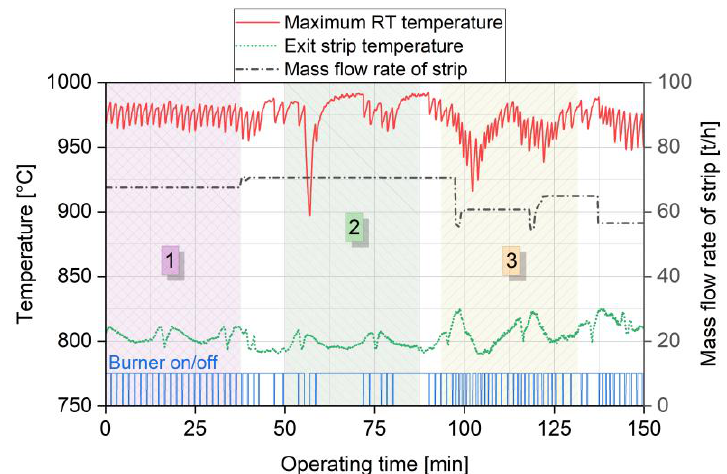
Figure 3. Example of temperature changes in a double P-type radiant tube in a CGL furnace: Region 1 representing the classic case of tube temperatures under burner on/off firing, Region 2 showing an instance of burner full load firing, and Region 3 illustrating tube temperature changes due to strip parameter variation.